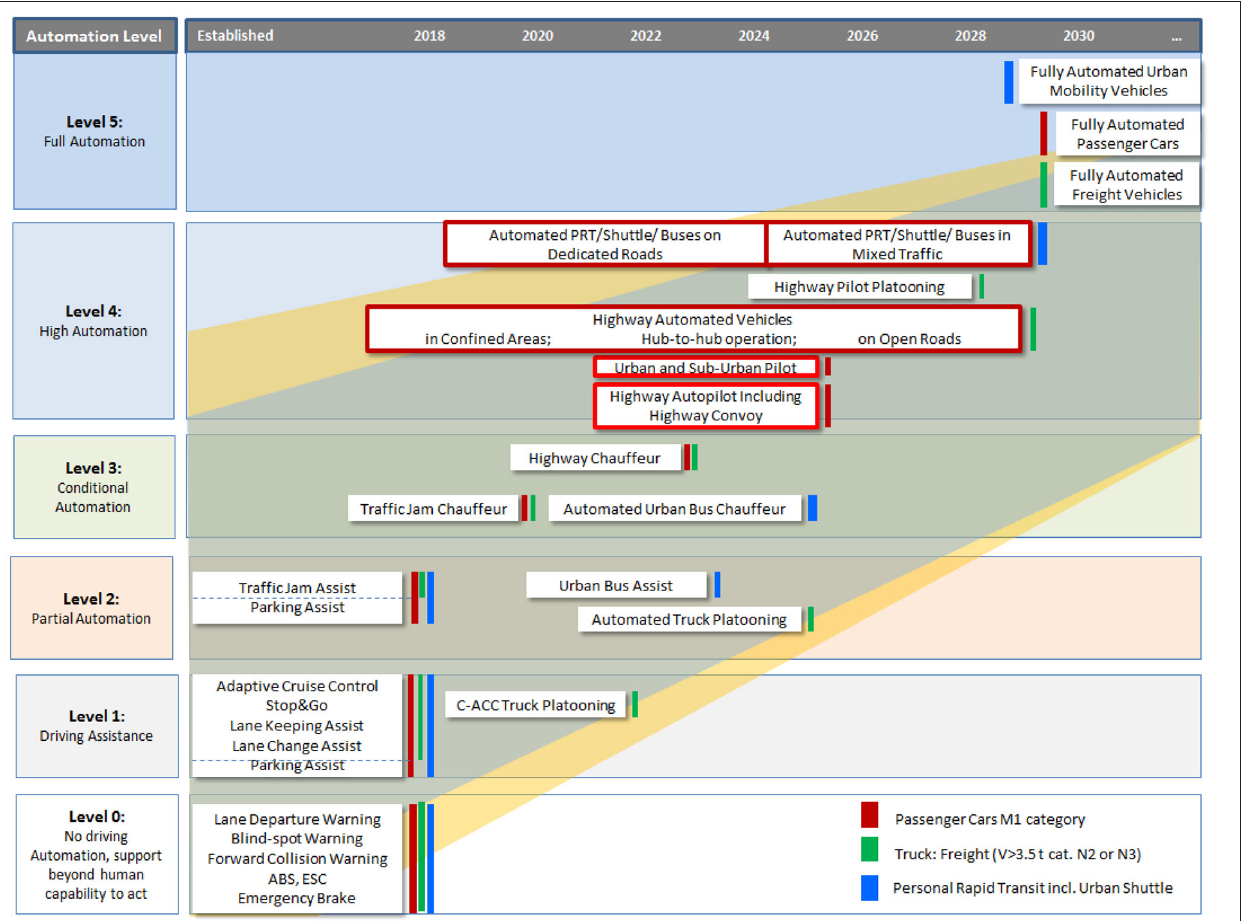
FIGURE 2 | Deployment path for Automated driving technology (Connected and Automated Driving Roadmap – ERTRAC – 3/2019), vehicle freight, and public